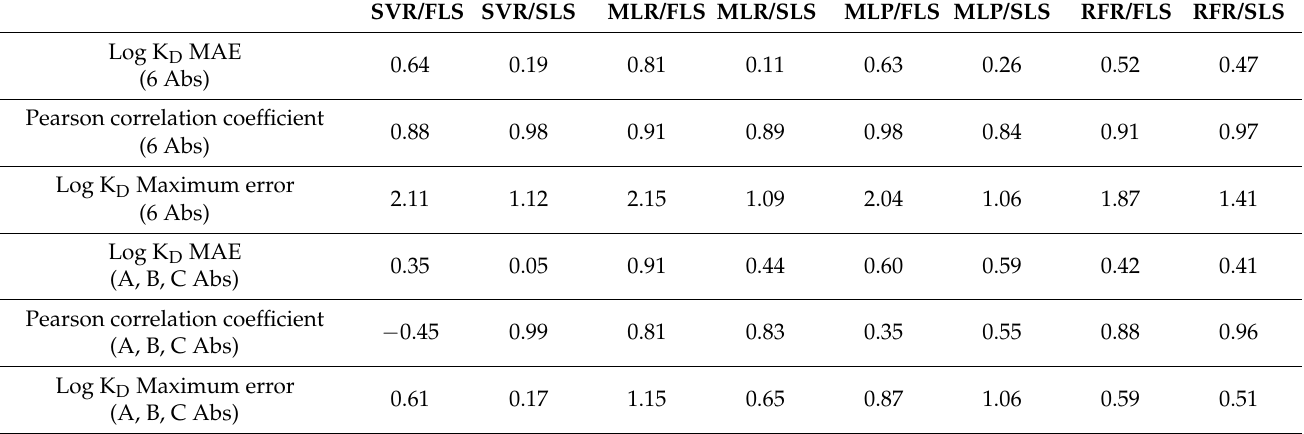
Table 3. Comparison between MAE, Pearson correlation coefficient, and maximum error between predictions at pH 7.0 and measurements for the 6 antibodies of Table 2 or only for the 3 produced variants (Mut3, Mut5, and